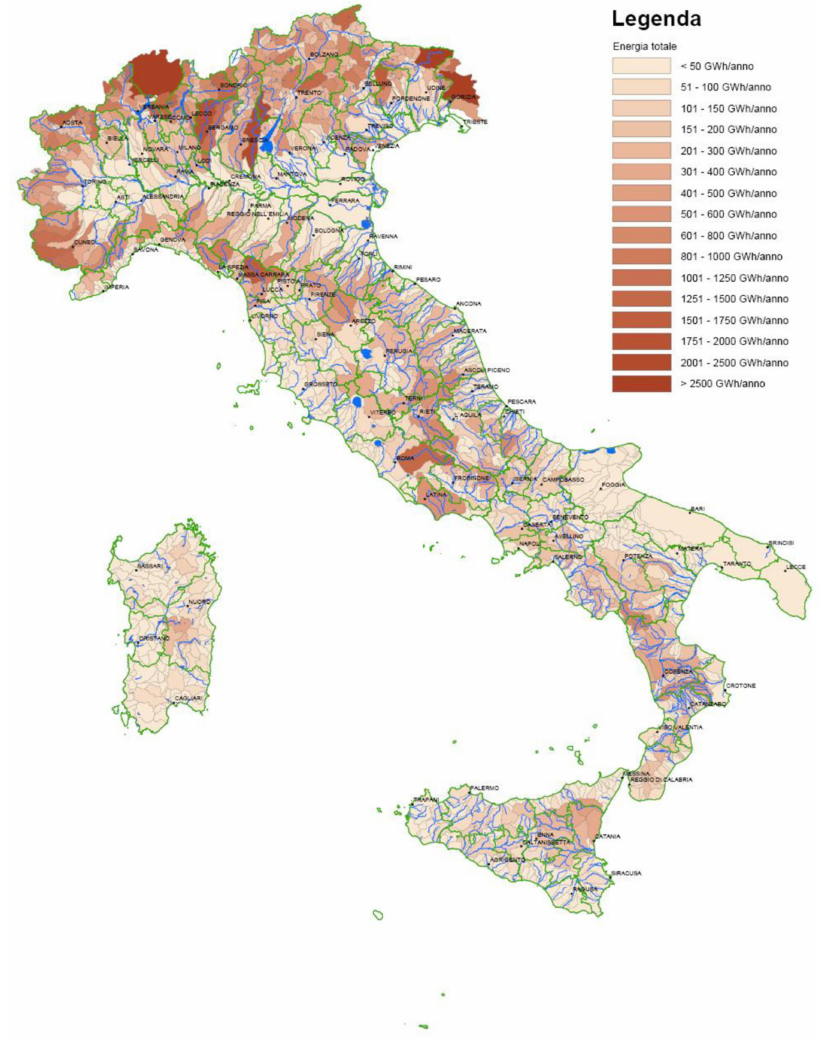
Figure 1. Map of maximum annual hydroelectric production in Italy (Source: ERSE SpA, https: //www.erseambiente.it/, accessed on 15 April 2021).